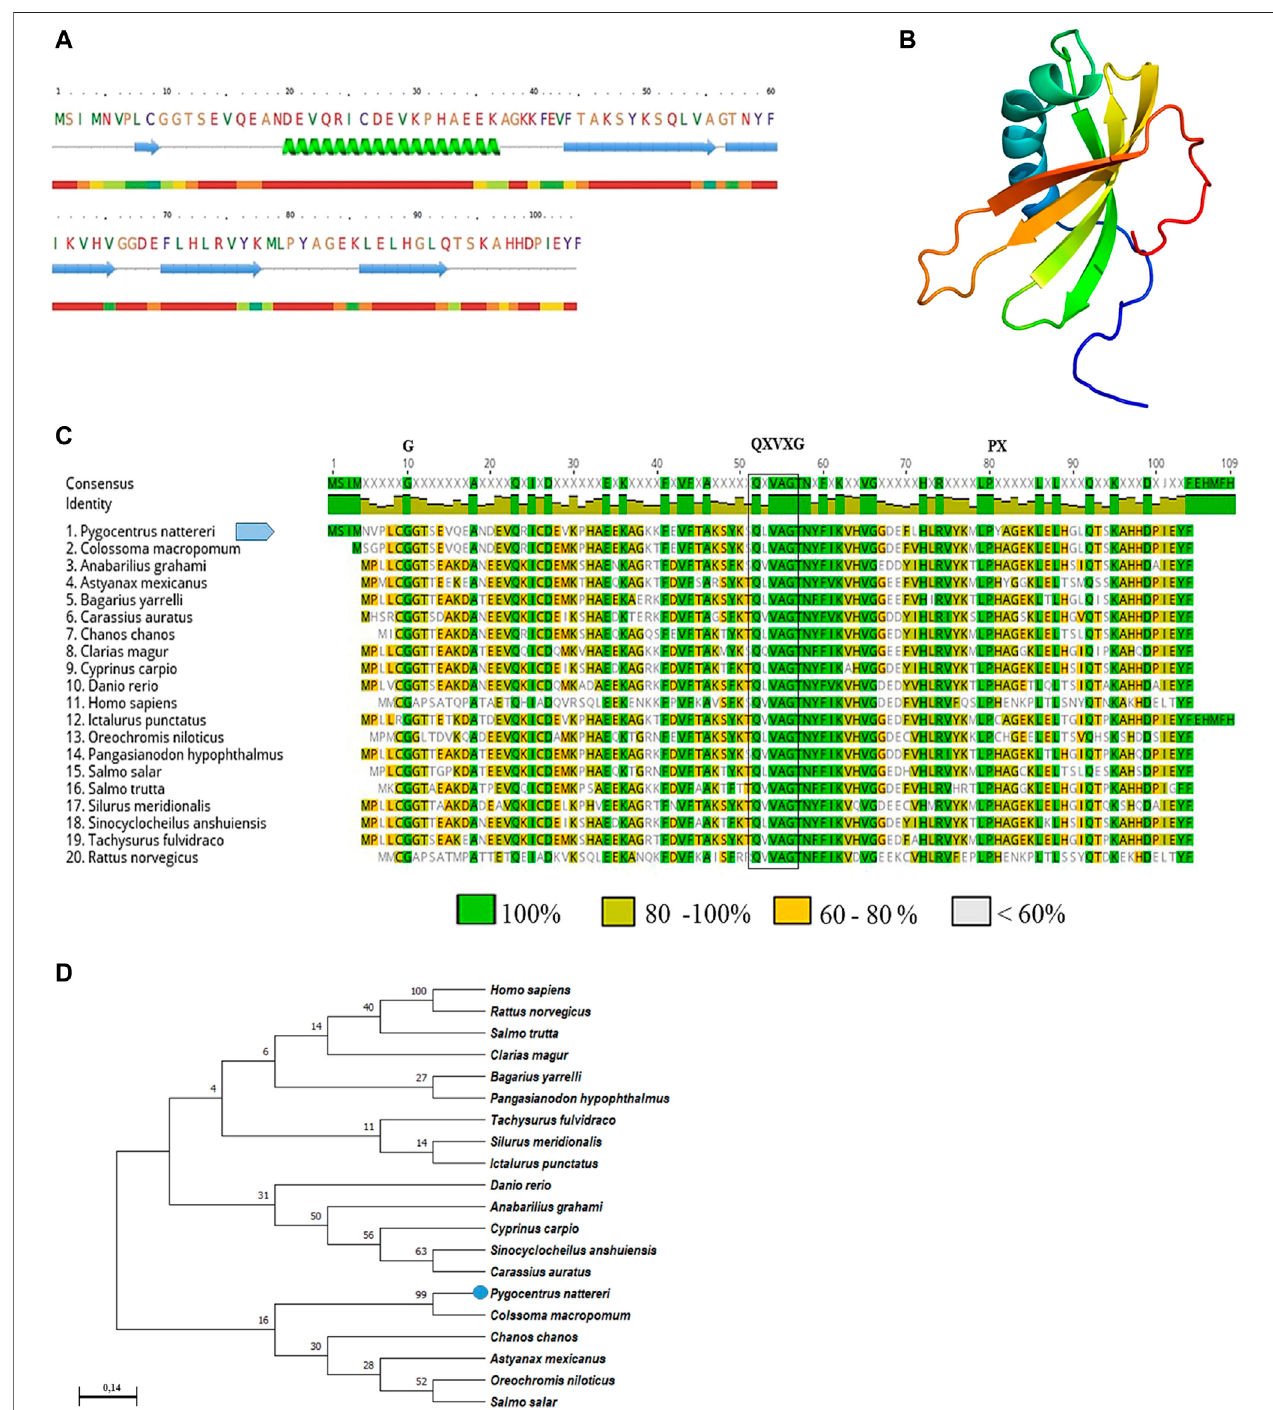
FIGURE2| Bioinformaticanalysisof Pygocentrusnattereri cystatin-B (A) .Secondarystructureofcystatin-Bof P.nattereri generatedbyPredictProteinandPhyre2 system. fx1 Alpha helix, fx2Beta Strand. (B) . The 3D tertiary structure of Cystatin-B generated by the Phyre2 system. Model dimensions (Å): X:44,068 Y:34.294 Z: 30.445. (C) . Multiple alignments of the cystatin-B amino acid sequence of Pygocentrus nattereri and other sequences. Colossoma macropomum, XP_036414104.1; Anabarilius grahami, ROK23366.1 ; Astyanax mexicanus, XP_007249105.1; Bagarius yarrelli, TSK98422.1; Carassius auratus , XP_026093937.1; Chanos , XP_030625480.1; Clarias magur , KAF5903616.1; Cyprinus carpio , XP_018952861.1; Danio rerio , NP_001096599.1; Homo sapiens , NP_000091.1; Ictalurus punctatus , XP_017308724.1; Oreochromis niloticus , XP_003443657.1; Pangasianodon hypopthalmus , XP_026793986.1; Salmo salar , XP_014062104.1; Salmo trutta , XP_029625791.1; Silurus meridionalis , KAF7691695.1; Sinocyclocheilus anshuiensis , XP_016296734.1; Tachysurus fulvidraco , XP_027030842.1; Rattus norvegicus , NP_036970.1. Characteristic and conserved residues of glycine ( G ) and proline (P) are indicated by the letter “ G ” and “ P ” , respectively. The characteristic and preserved residues of the QXVXG motif are marked with a box. (D) . Phylogenetic tree of cystatin-B and sequences of their counterparts constructed using the neighbor-joining method and 1000 bootstrap replicates. The numbers presented in the branches represent the bootstrap value (%). Frontiers in Genetics |